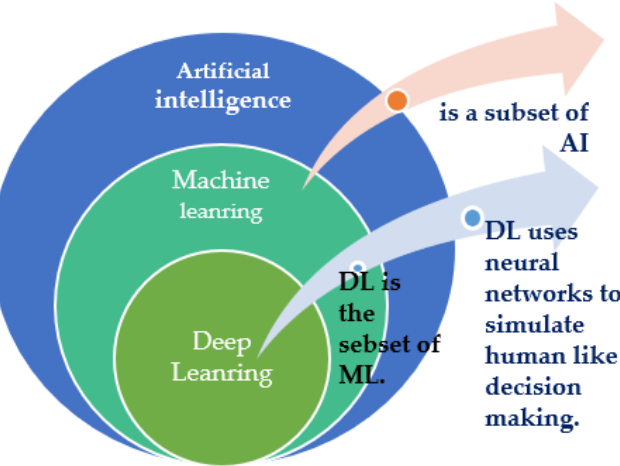
Figure 14. Representation of artificial intelligence, machine learning, and deep learning (Note: AI—artificial intelligence, DL—deep learning, ML—machine learning).